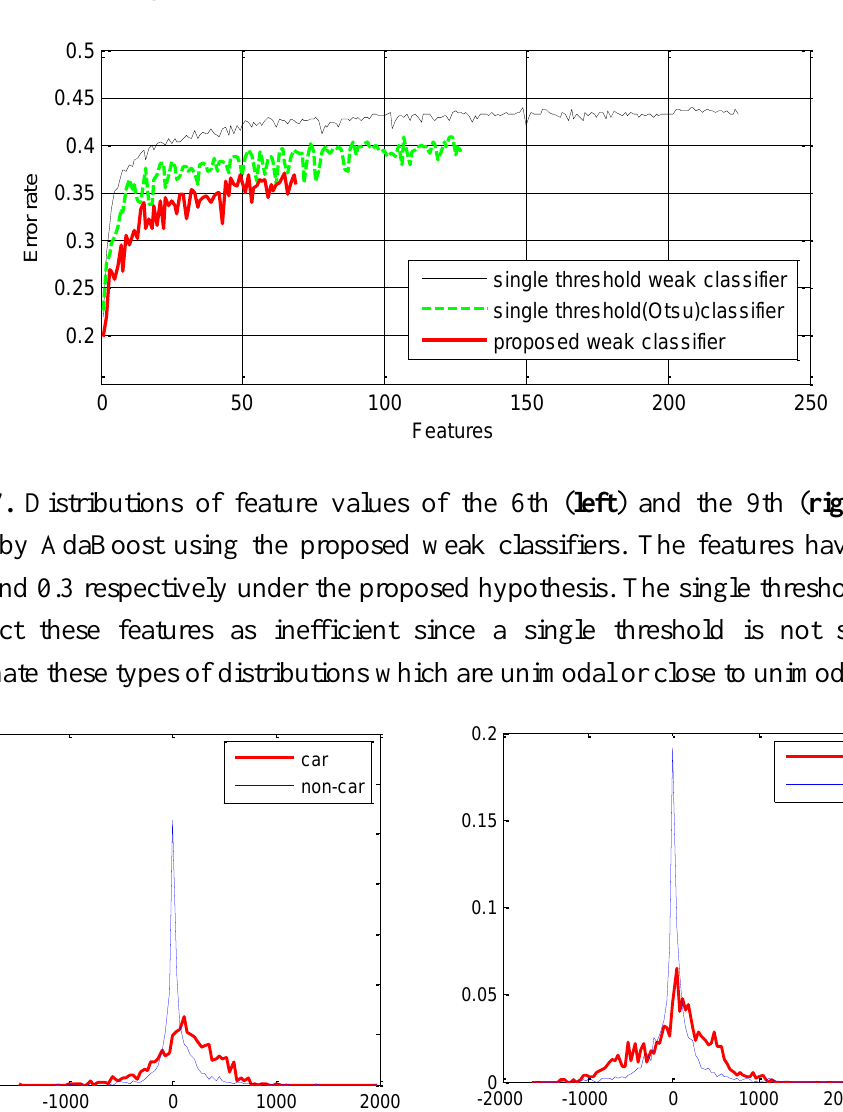
Figure 6. Error rates of the weak classifiers selected by boosting using proposed weak classifiers and the single threshold weak classifiers.